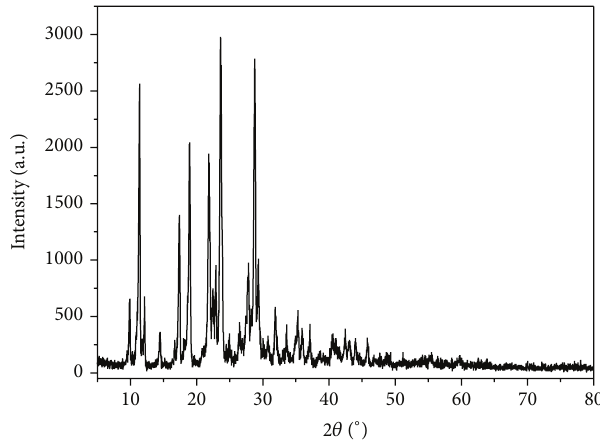
Figure 9: X-ray powder diffraction pattern of biuret.